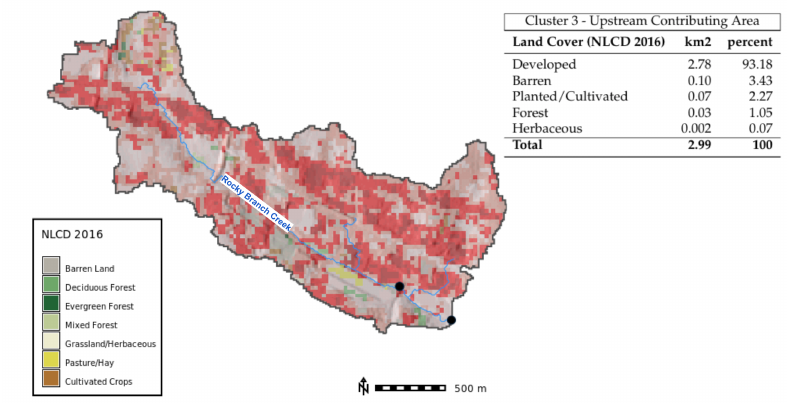
Figure 14. Cluster 3—Cluster 3 is located at North Carolina State University in Raleigh, North Carolina and has an upstream contributing area of 2.99 km 2 that is 93% developed. Pluvial flooding was modeled using a 100-year precipitation event and indicated that water can accumulate up to depths of 1.15 m. A one-meter maximum inundation was also simulated, showing 2000 m 2 maximum flood extent with water depths reaching 4.6 m (Figure